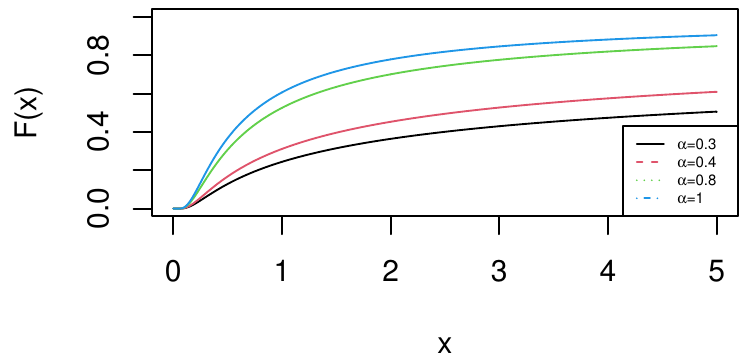
Figure 4. Graph of the CDF of GIED for λ =